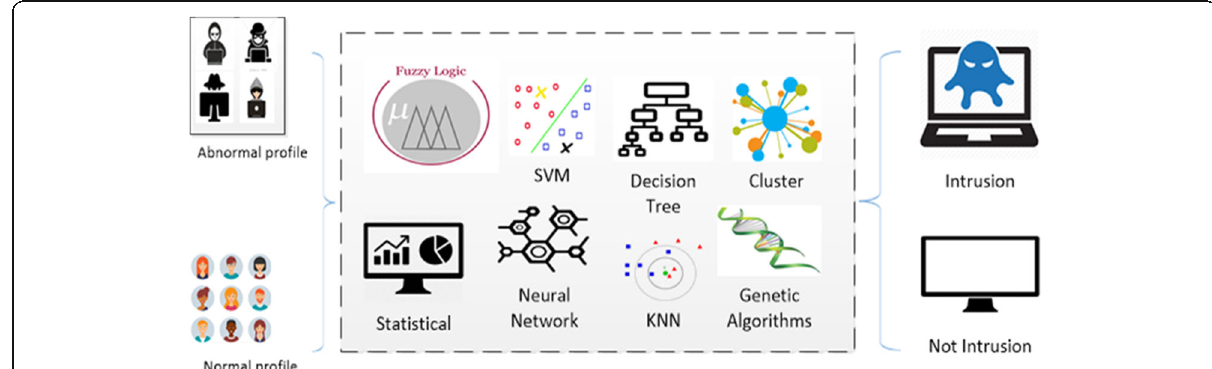
Fig. 4 Conceptual working of AIDS approaches based on machine